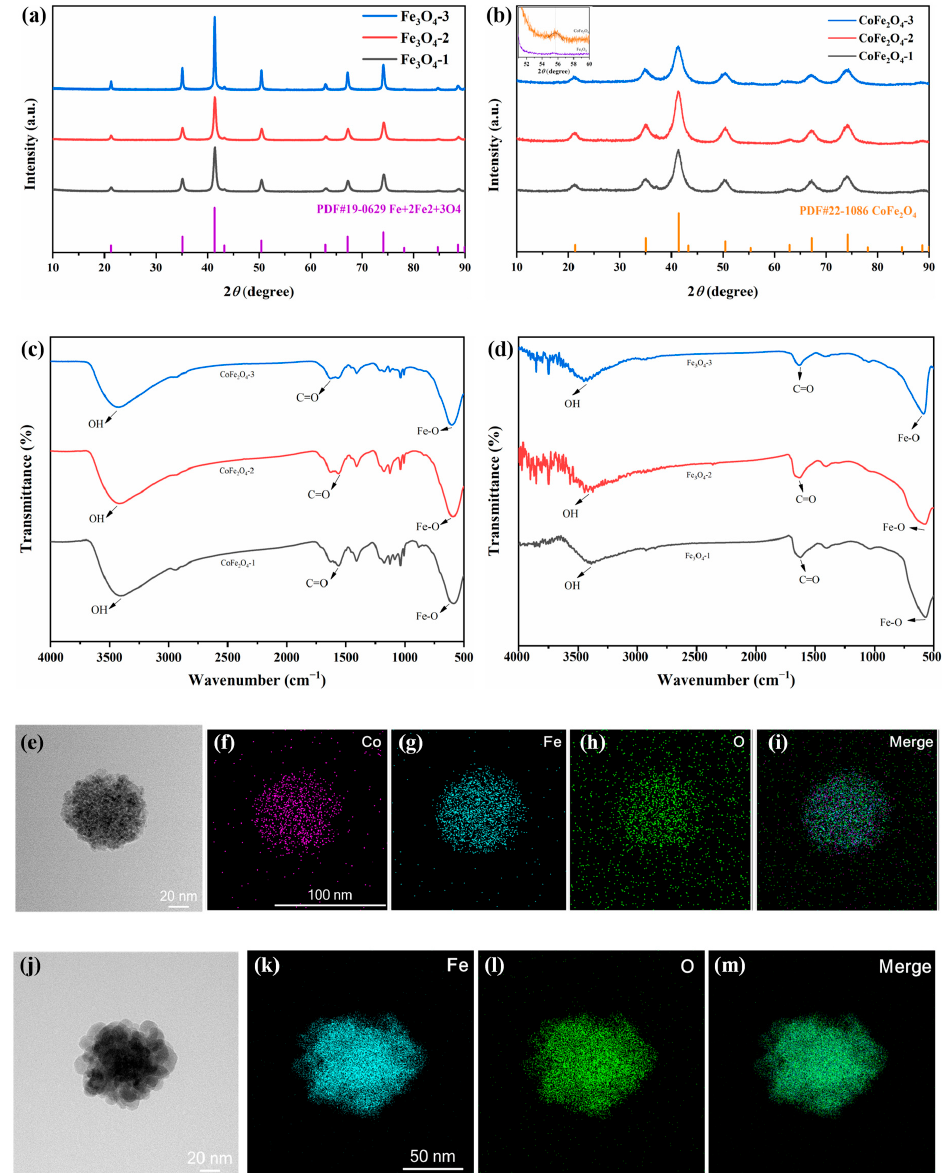
Figure 2. Characterization of CoFe 2 O 4 nanozyme and Fe 3 O 4 nanozyme by XRD and FTIR. ( a ) XRD spectrum of Fe 3 O 4 nanozymes. ( b ) XRD spectrum of CoFe 2 O 4 nanozymes. ( c ) FTIR of CoFe 2 O 4 nanozymes. ( d ) FTIR of Fe 3 O 4 nanozymes. ( e – i ) Images of TEM and corresponding EDS elemental mapping of CoFe 2 O 4 nanozyme. ( j – m ) Images of TEM and corresponding EDS elemental mapping of Fe 3 O 4